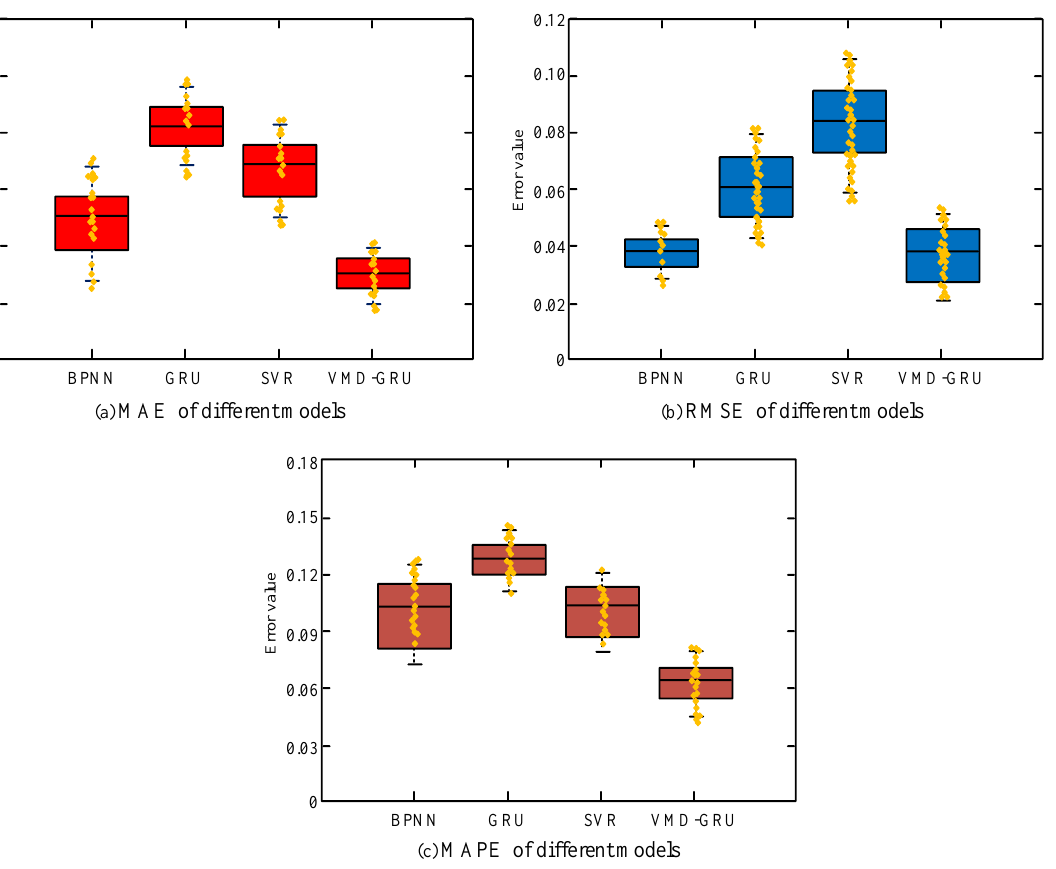
Figure 11. Comparison of MAE, RMSE, and MAPE values under different algorithm models.